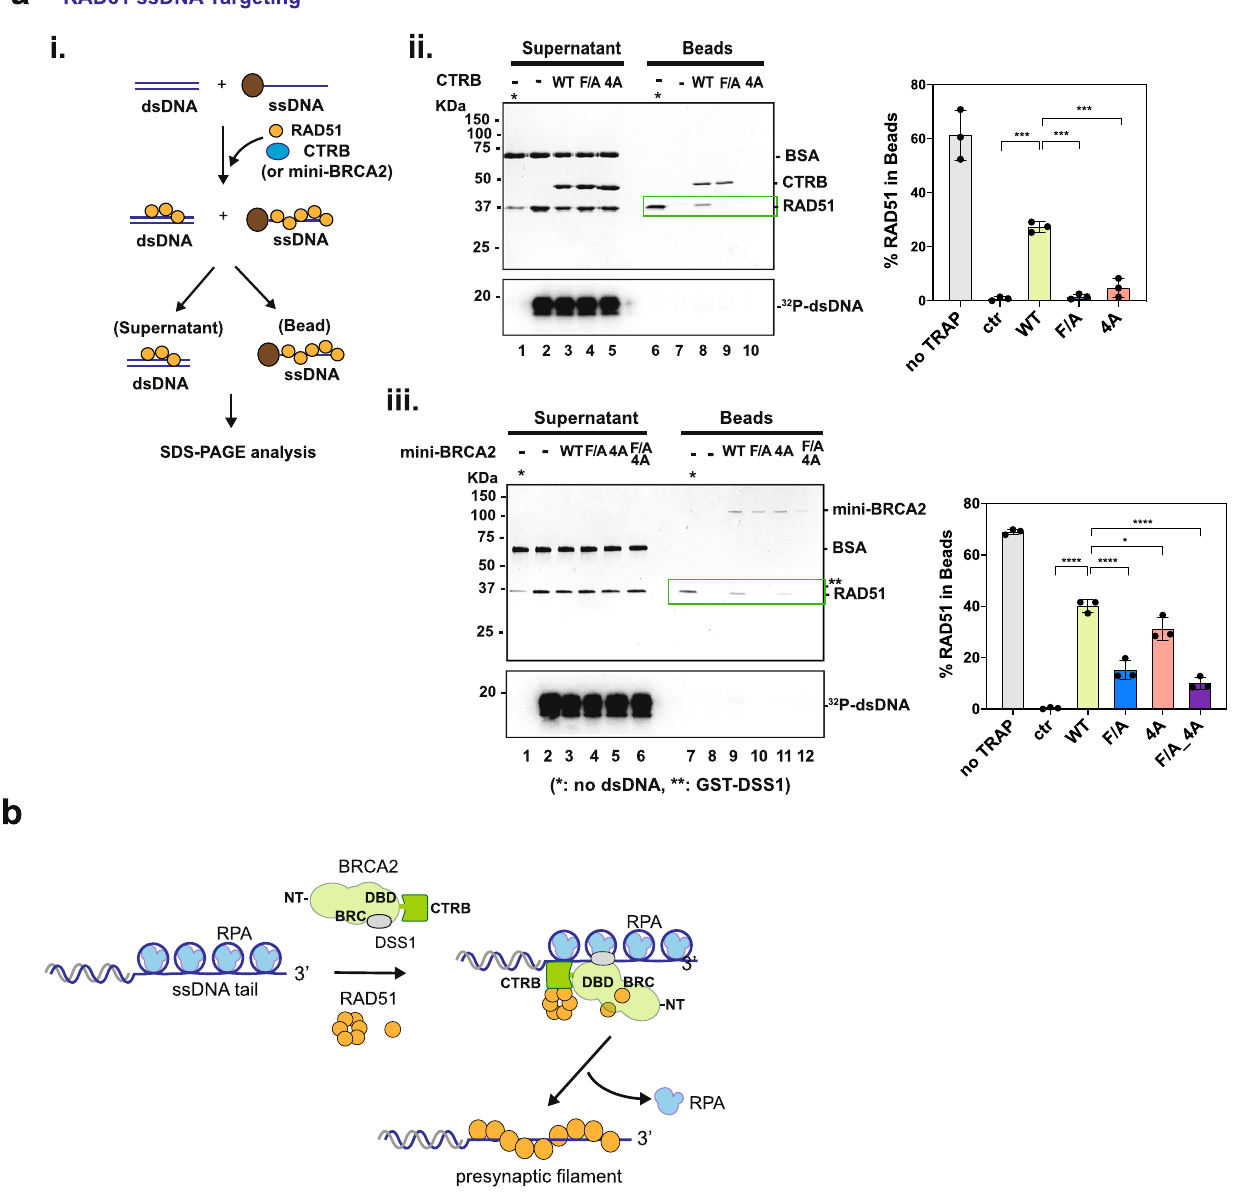
Fig. 4 | Targeting of RAD51 to ssDNA by CTRB and mini-BRCA2. a ( i ) Schematic of the assay. The magnetic resin containing ssDNA was incubated with RAD51 and CTRB ( ii ), or mini-BRCA2/DSS1 ( iii ) with and without an excess of radiolabeled dsDNA added as a protein trap. Proteins bound to the ssDNA (Beads) were eluted and analyzed alongside the reaction supernatant(Supernatant) by SDS-PAGE and Coomassie blue staining. The results were quanti fi ed and graphed.